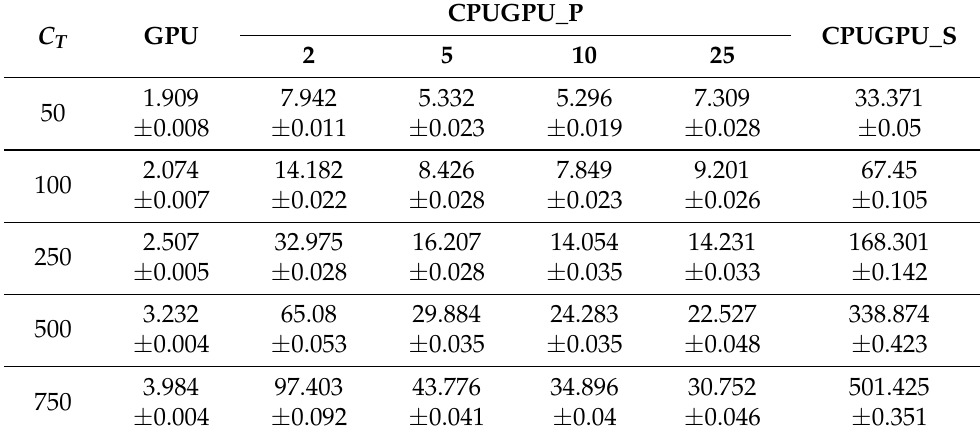
Table 6. Effect of number of observations on computation time. Results of experiments for constant action with DNN model ( C S =